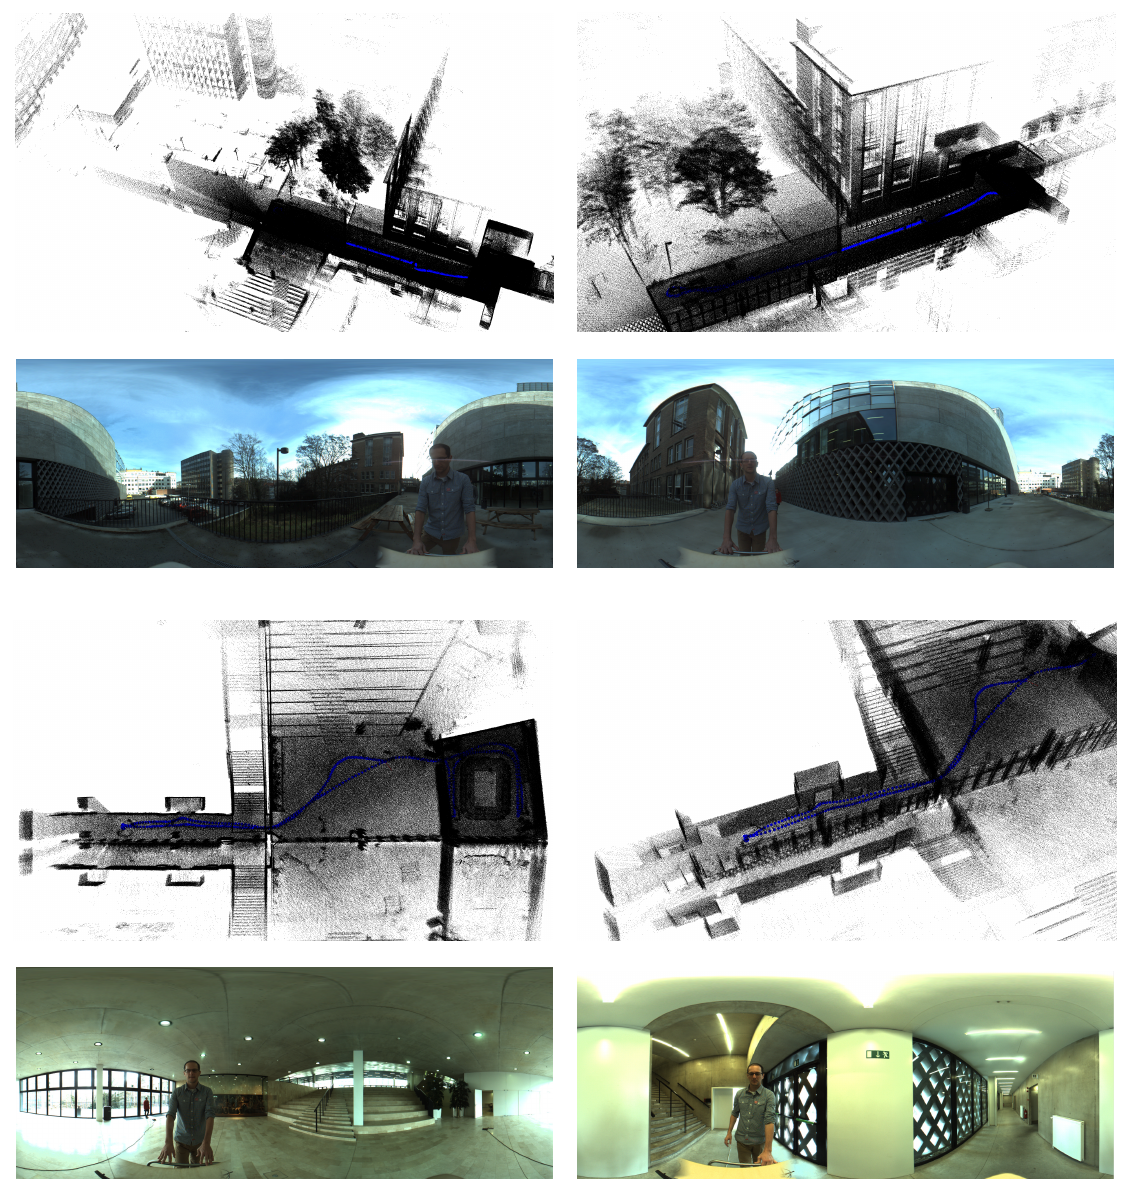
Figure 17. Some example images of the 3D reconstructions obtained by applying our algorithm on the recordings of a campus of Ghent